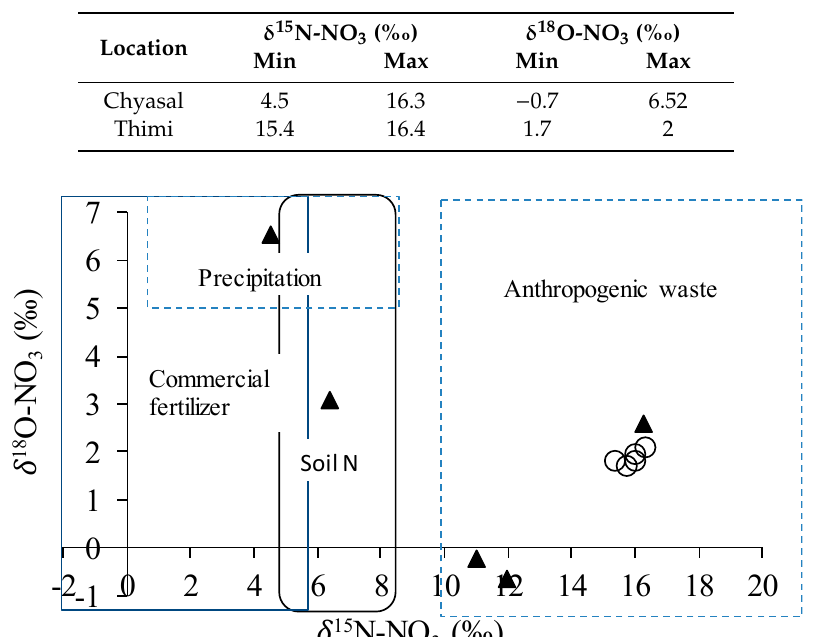
Table 3. Distributions of stable isotopes of oxygen and nitrogen from nitrate in Chyasal and Thimi.